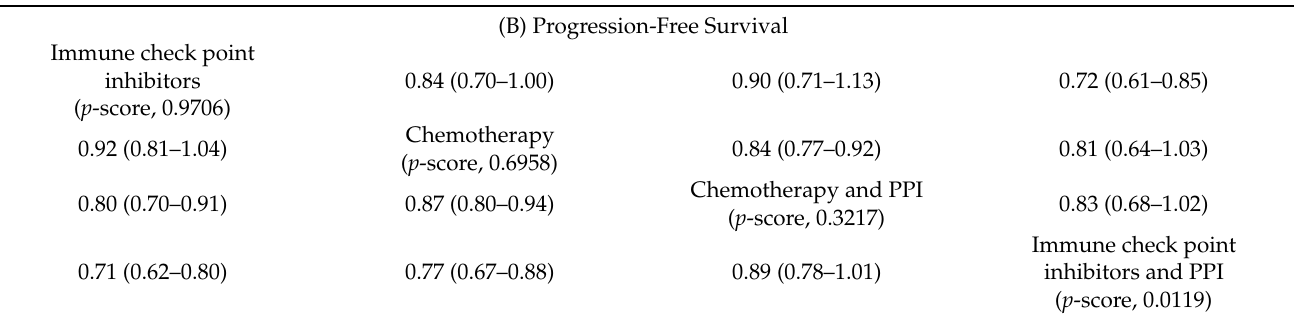
Table 2. Cont. (B) Progression-Free Survival (B) Progression-Free Survival